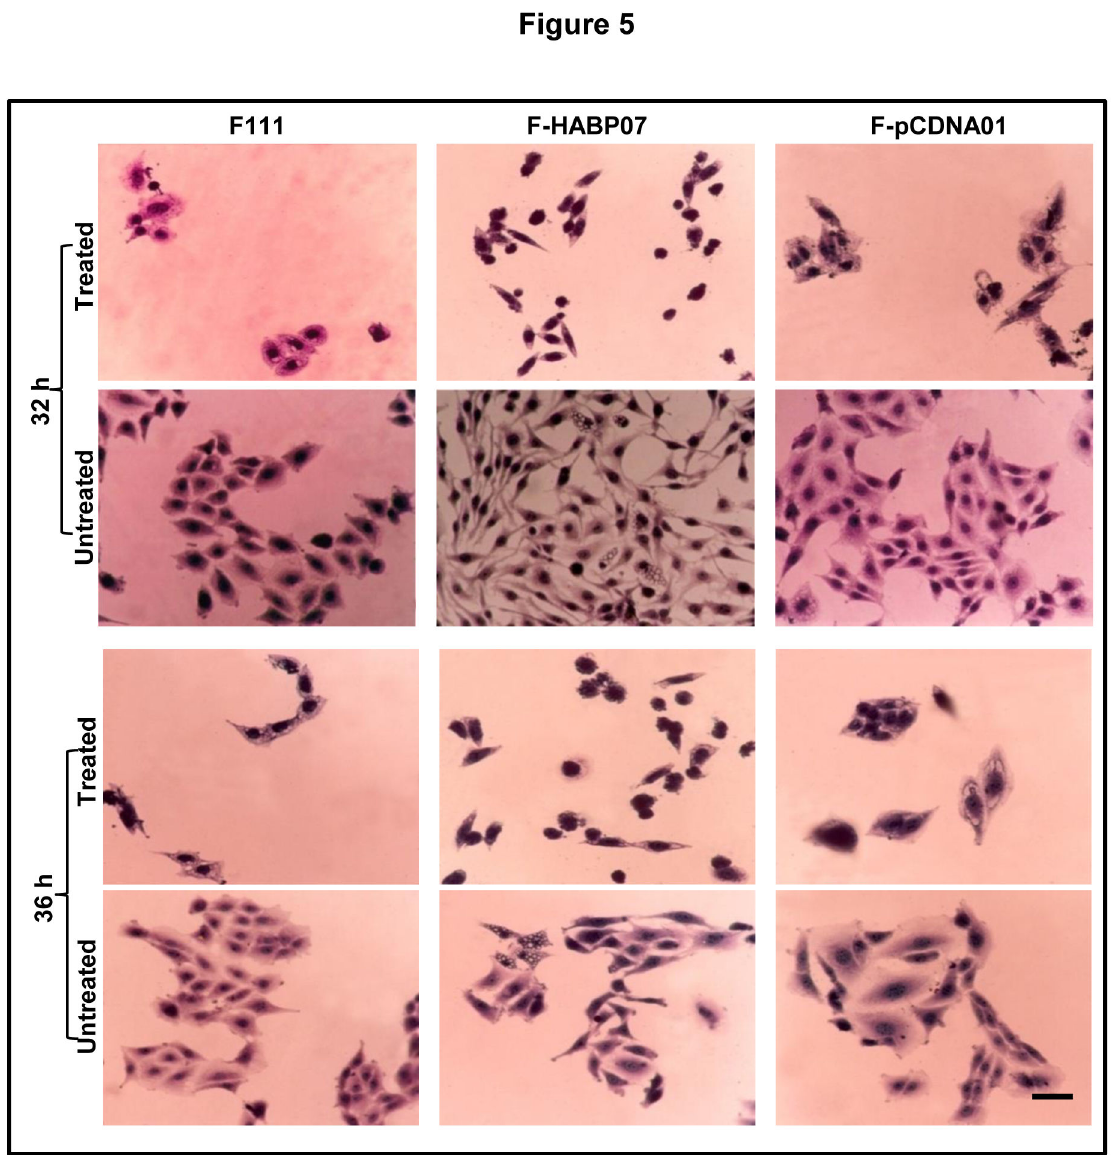
Figure 5. Proteasome inhibitor MG132 leads to cell death in HABP1 overexpressing fibroblasts. Haematoxylin - Eosin staining after treatment of F111, F-HABP07 and F-pCDNA01 with proteasome inhibitor MG132 (5mM, 12 h) both at 32 h and 36 h leads to cell death in HABP1 overexpressing fibroblasts while the normal and the vector transformed fibroblasts showed generation of vacuoles. Scale=10µm